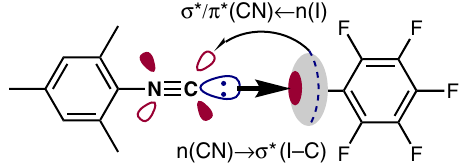
Fig. 5 Intermolecular charge transfer along the XB with isocyano group. Two different directions of the intermolecular charge transfer along I···C XB in the supramolecular associate of (CNMes) (cid:129) IPFB referring to the n(CN) → σ *(I − C) and n(I) → σ */ π *